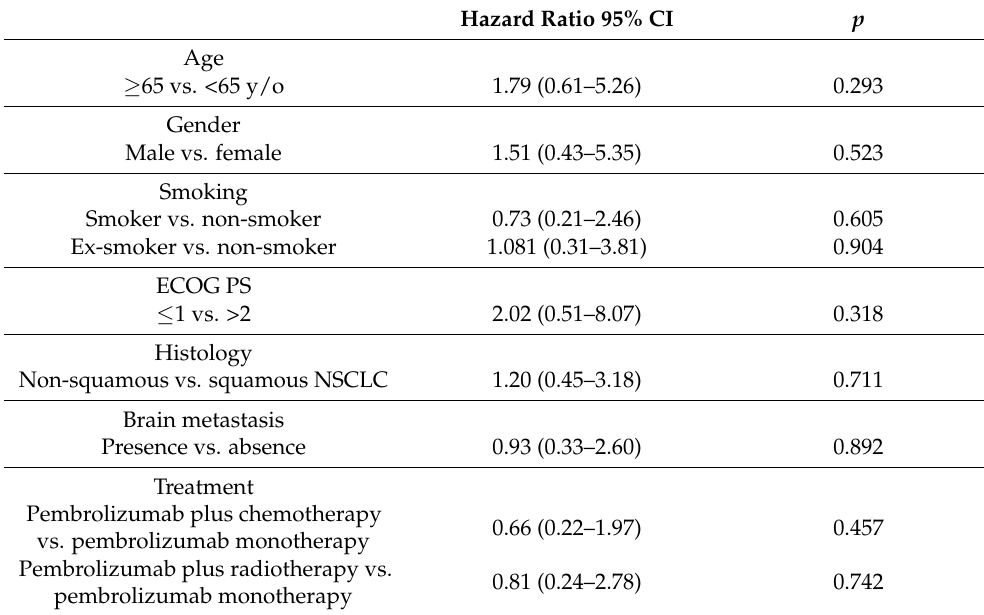
Table 3. Cox proportional hazard regression analysis of